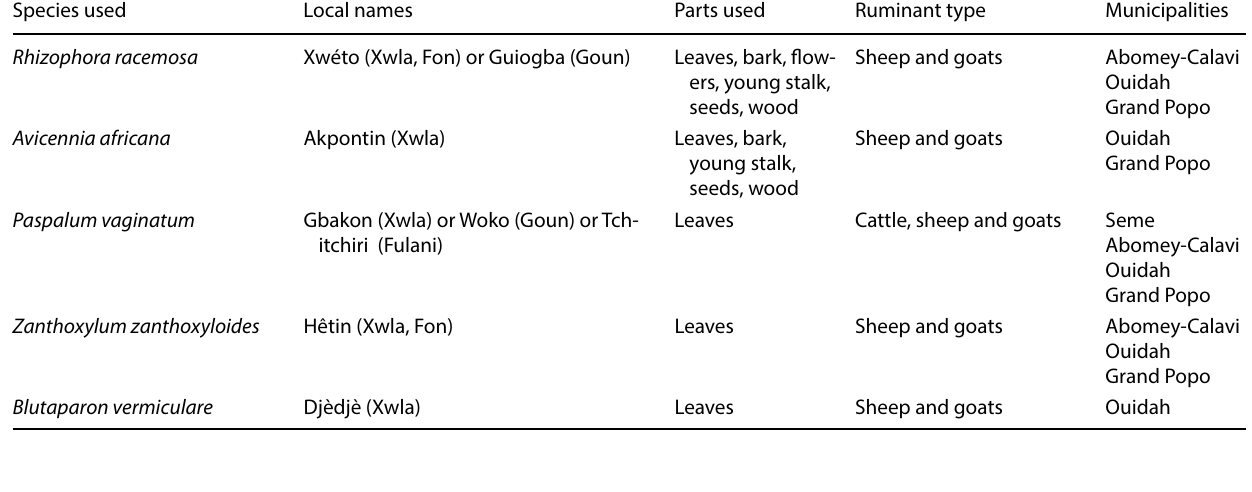
Table 2 Use categories, citation rate, and plant parts used in ruminant